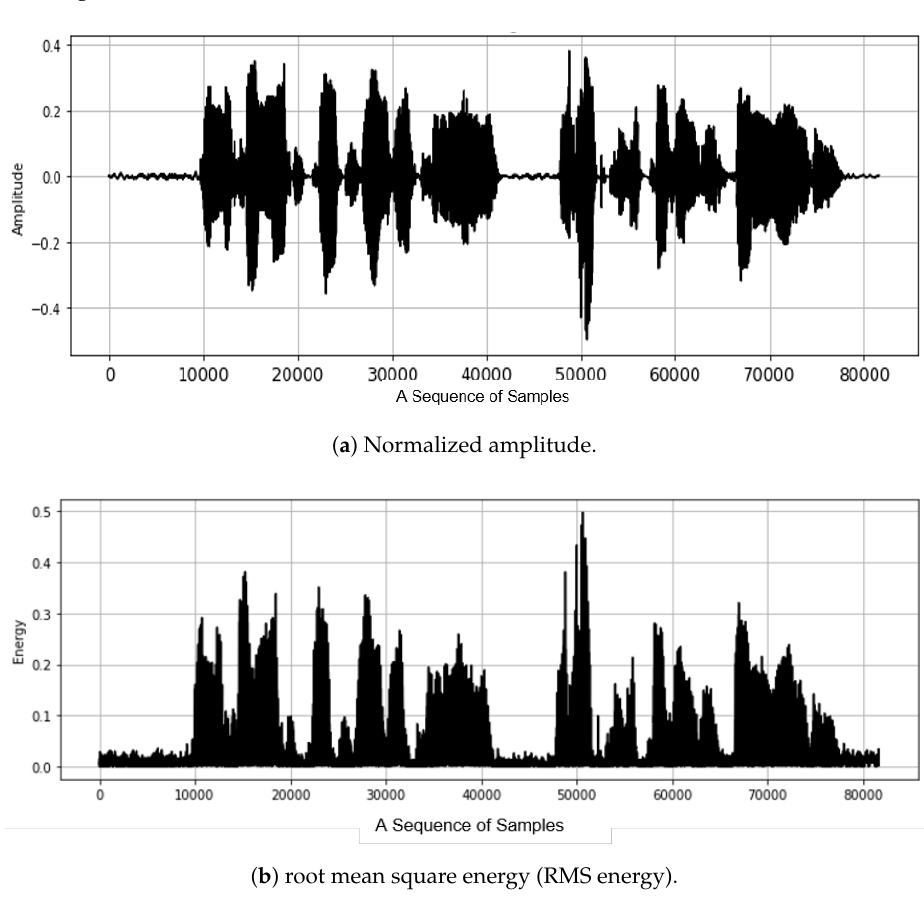
Figure 6. Normalized amplitude and RMS energy of a sample audio signal.